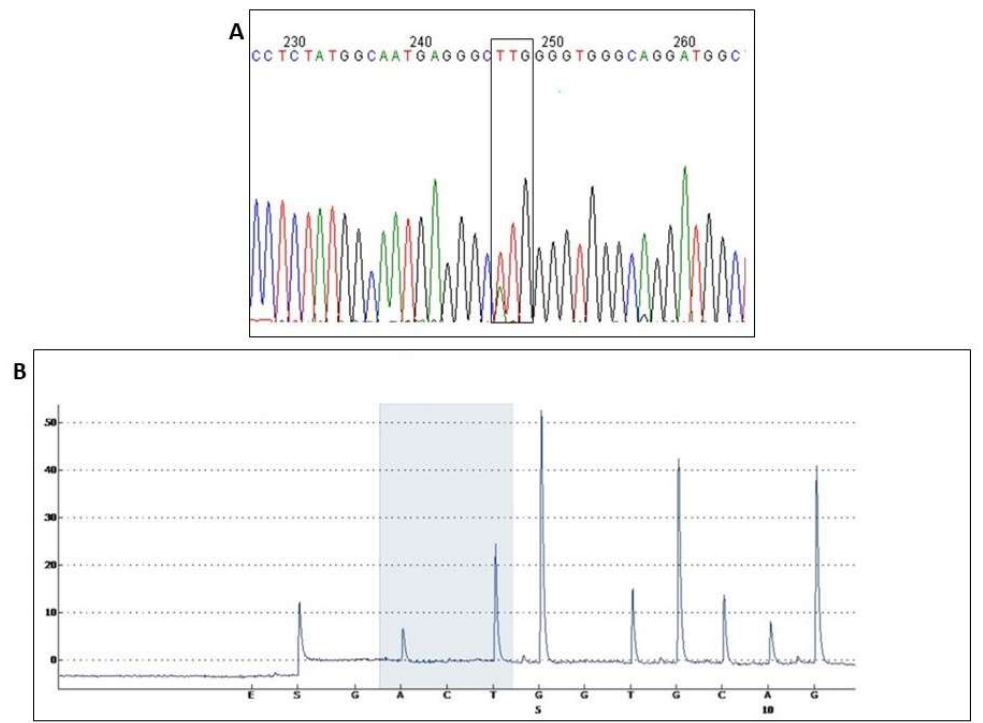
Figure 1. Results obtained by Sanger sequencing and pyrosequencing of sample 94. Chromatograms and pyrogram (( A , B ) respectively), with obvious nucleotide fluctuations ( A ), a thymine (T), which translates to leucine and an adenine (A) which encodes methionine overlap. Pyrosequencing confirms and quantifies this variation, which shows a slight difference between the presence of the two subpopulations (T nucleotide, wild type; and A, mutant type).